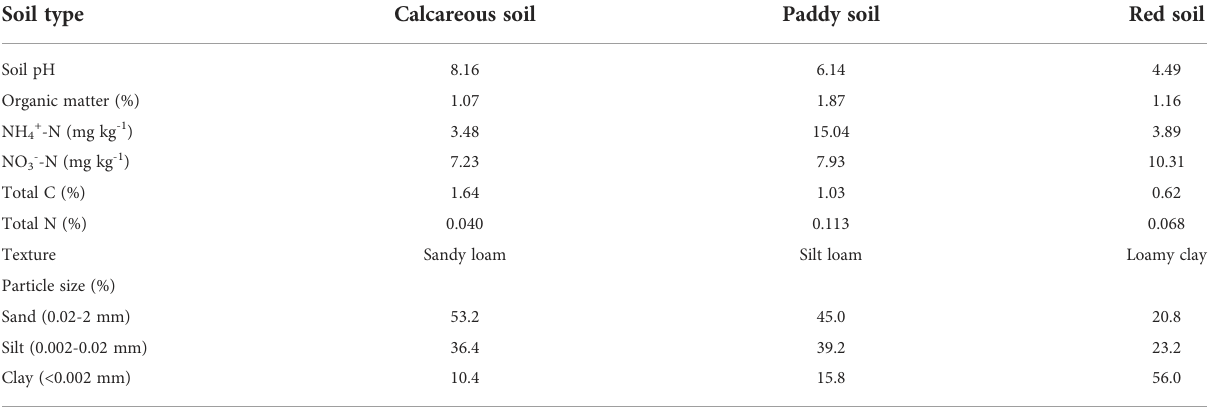
TABLE 1 Physicochemical characteristics of the tested three